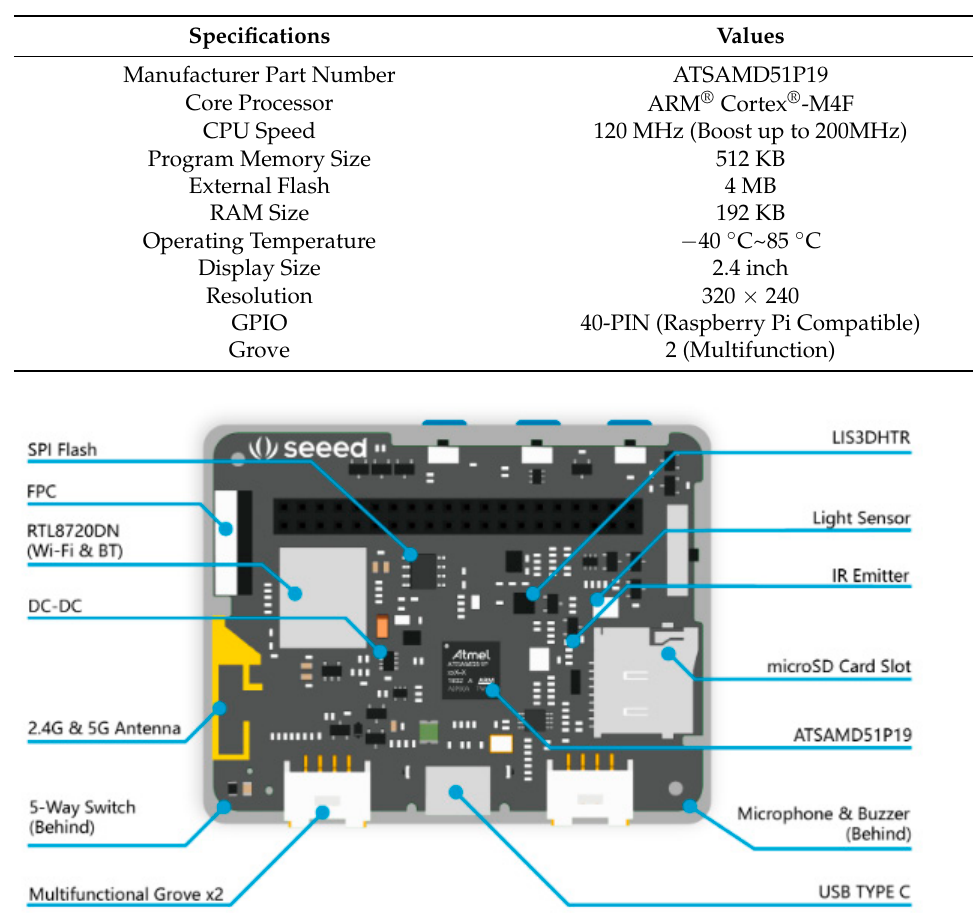
Figure 6. Hardware overview of the Wio terminal.